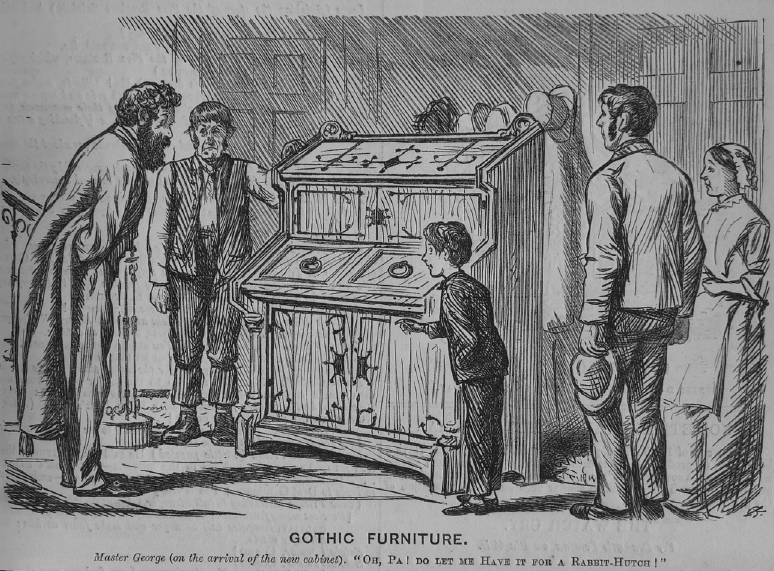
Figure 5: Punch cartoon lampooning Eastlake-style furniture (November 18, 1865, 195. Courtesy Mr I.